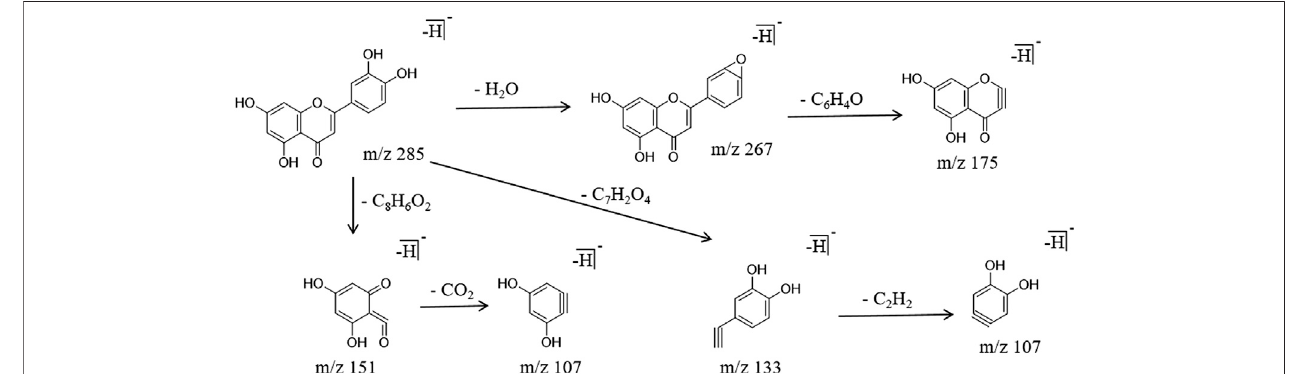
FIGURE 5 | Cracking pathway of fl